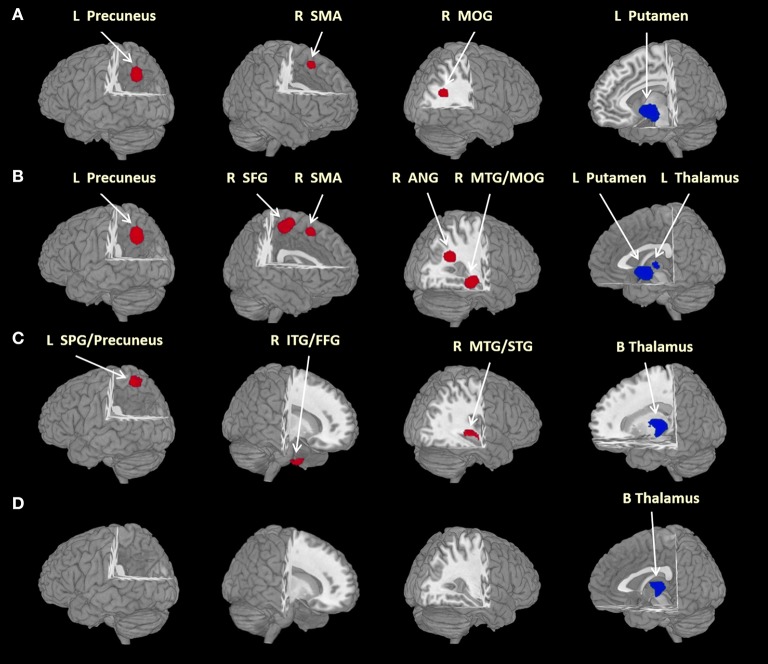
Brain regions differed significantly between groups. Areas of larger (red) and smaller (blue) brain GMVs in patients compared with healthy controls in the meta-analyses. Images are presented in radiological orientation. (A) Areas of larger and smaller brain GMVs in all patients with social anxiety disorder compared with healthy controls; (B) areas of larger and smaller brain GMVs in adult patients with social anxiety disorder compared with healthy controls; (C) areas of larger and smaller brain GMVs in patients without comorbid depressive disorder compared with healthy controls; (D) areas of smaller brain GMVs in currently drug-free patients compared with healthy controls. ANG, angular gyrus; B, bilateral; FFG, fusiform gyrus; GMV, gray matter volume; ITG, inferior temporal gyrus; L, left; MOG, middle occipital gyrus; MTG, middle temporal gyrus; R, right; SFG, superior frontal gyrus; SMA, supplementary motor area; SPG, superior parietal gyrus; STG, superior temporal gyrus. Statistical inferences were made with a voxel-level statistical threshold (p < 0.005) and a minimum cluster size of more than 10 voxels.